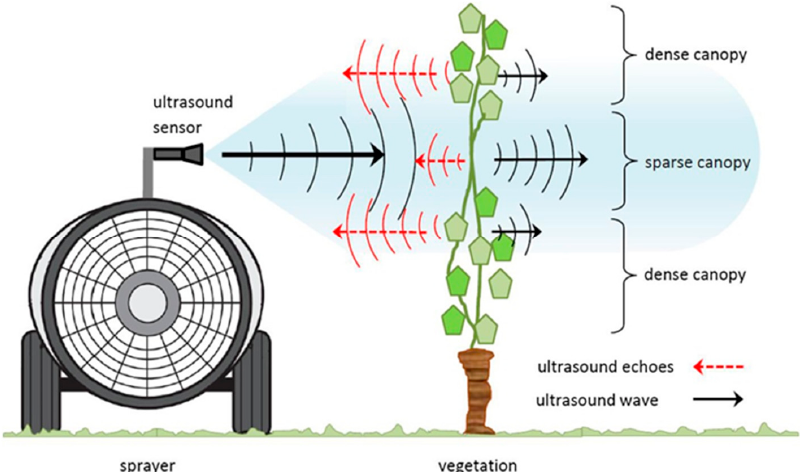
Figure 2. Schematic diagram of canopy density measurement with the ultrasonic sensor